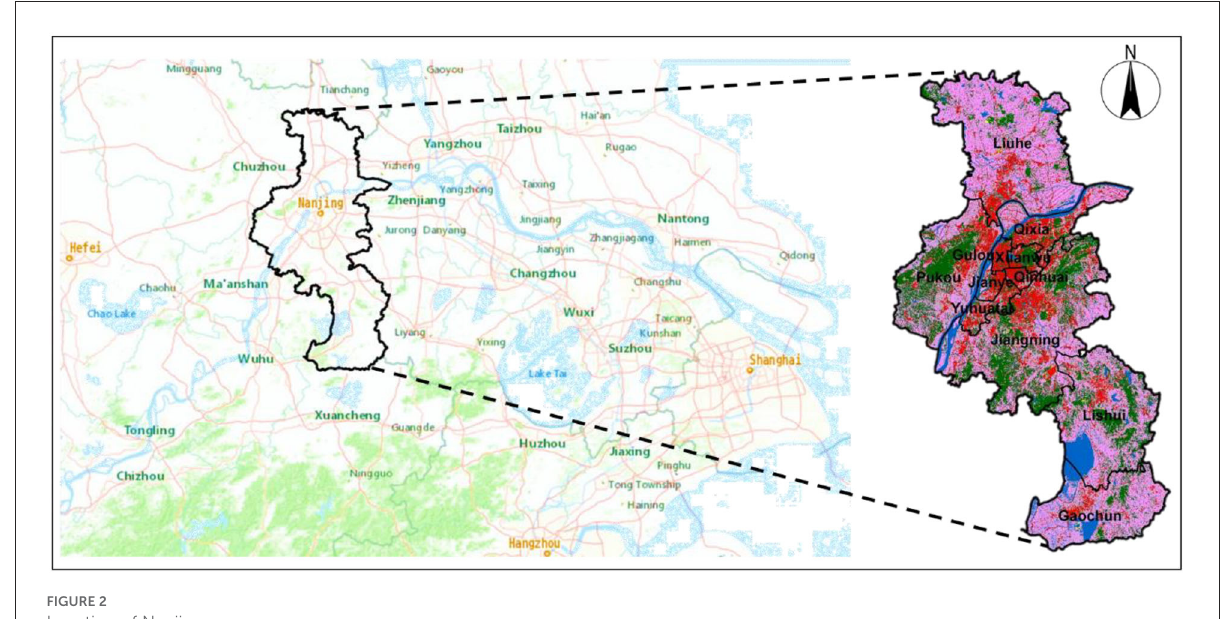
FIGURE2 Location of